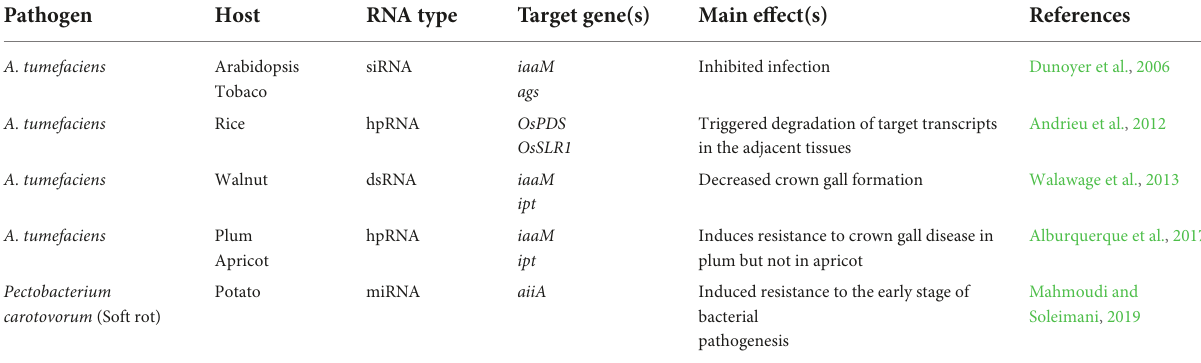
TABLE 2 Summary of HIGS applications for control of bacterial